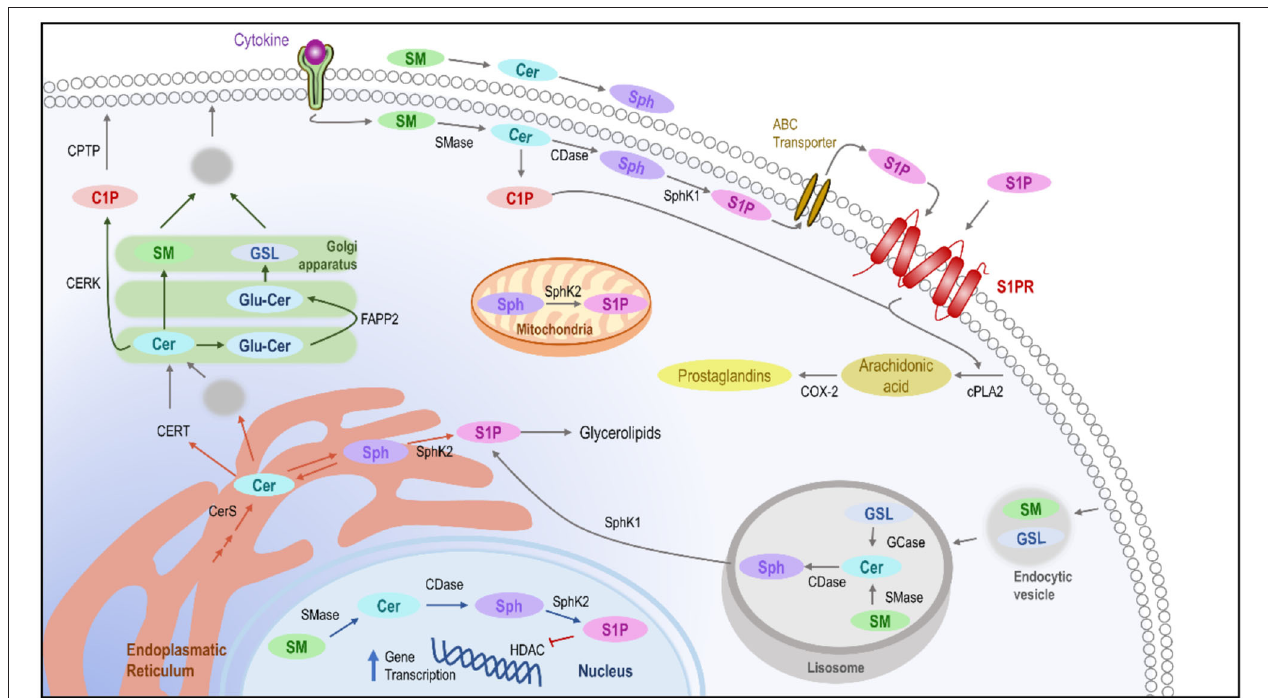
FIGURE 1 | Intracellular pathways of sphingolipids. De novo ceramide synthesis takes place in the ER where it might be delivered to the Golgi apparatus using the ceramide transfer protein by vesicular transport to synthesize sphingomyelin glucosylceramide or C1P, which will become part of the plasmatic membrane. In the membrane, after the presence of stimuli, the different enzymes implicated in the homeostasis of the sphingolipids are activated, leading to the production of C1P and S1P, which in the end leads to the activation of phospholipase-A2 and the production of prostaglandins as inflammatory mediators. Moreover, the sphingolipids can also be metabolized in lysosomes, leading to the release of sphingosine and in the cellular nucleus, where S1P could block the transcription of genes related to inflammation. ER, Endoplasmic reticulum; C1P, Ceramide-1-Phosphate; CDase, Ceramidase; CER, Ceramide; CERK, Ceramide kinase; CERS, Ceramide Synthase; CERT, Ceramide transfer protein; CPTP, Ceramide-1-phosphate protein transport; GSL, Glucosylceramide; SM, Sphingomyelin; SMase, Sphingomyelinase; S1P, sphingosine-1-phosphate; SPH, Sphingosine; SphK, Sphingosine